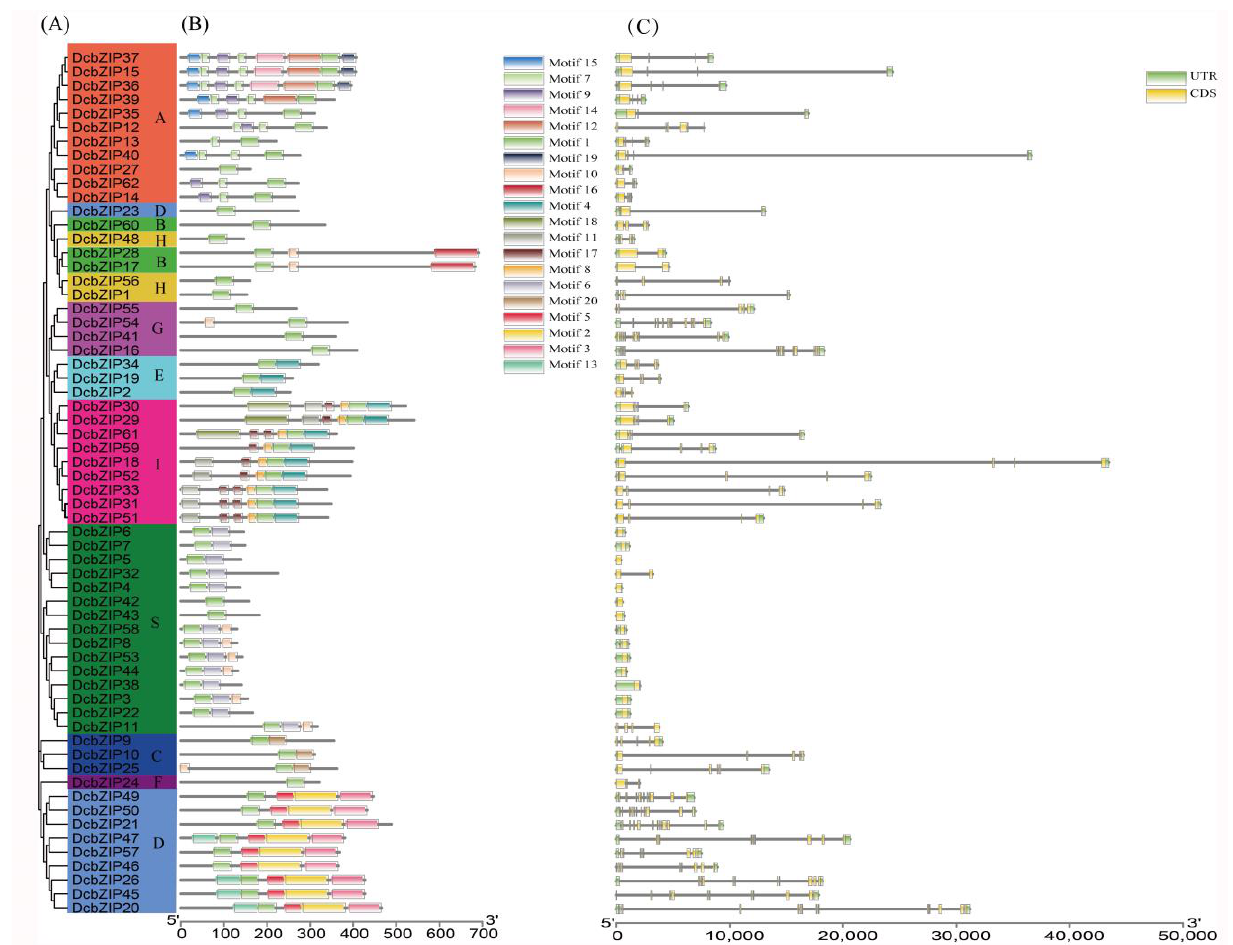
Figure 2. Motifs, structures and phylogenetic relationships of DcbZIP family members. ( A ) A phylogenetic tree of 62 DcbZIP proteins constructed using the maximum likelihood method. The different subgroups are indicated by different background colors and letters. ( B ) Conserved motifs of DcbZIP proteins. Different motifs are represented by different colored boxes. ( C ) Exon/intron structures of DcbZIP genes with UTR(s), exon(s) and intron(s) indicated with green boxes, yellow boxes and black lines, respectively. The phylogenetic tree, conserved motifs and gene structures were predicted with TBtools.